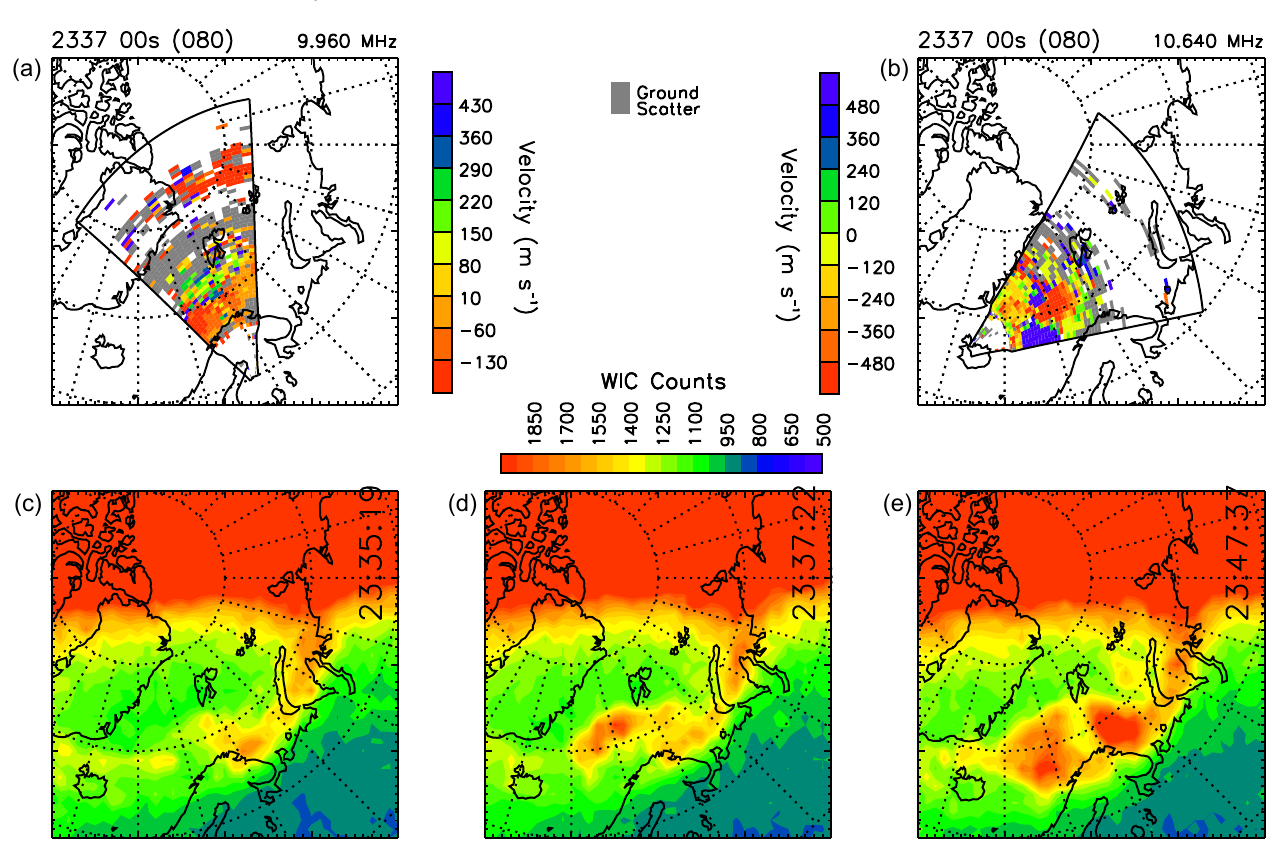
Fig. 2. Fields-of-view and data coverage from Channel A of the SuperDARN radars at (a) Hankasalmi, Finland and (b) Þykkvibær, Iceland in magnetic latitude-magnetic local time coordinates during substorm onset at 23:37UT. Red (negative) velocities are away from the radar and blue (positive) velocities are towards the radar. The radial dashed lines are separated by 1h local time, with local midnight being marked by the vertical dashed line. The dashed circles indicate magnetic latitude at 10 ◦ separations. (c–e) present IMAGE WIC auroral data in the same coordinate system for three times during the substorm expansion